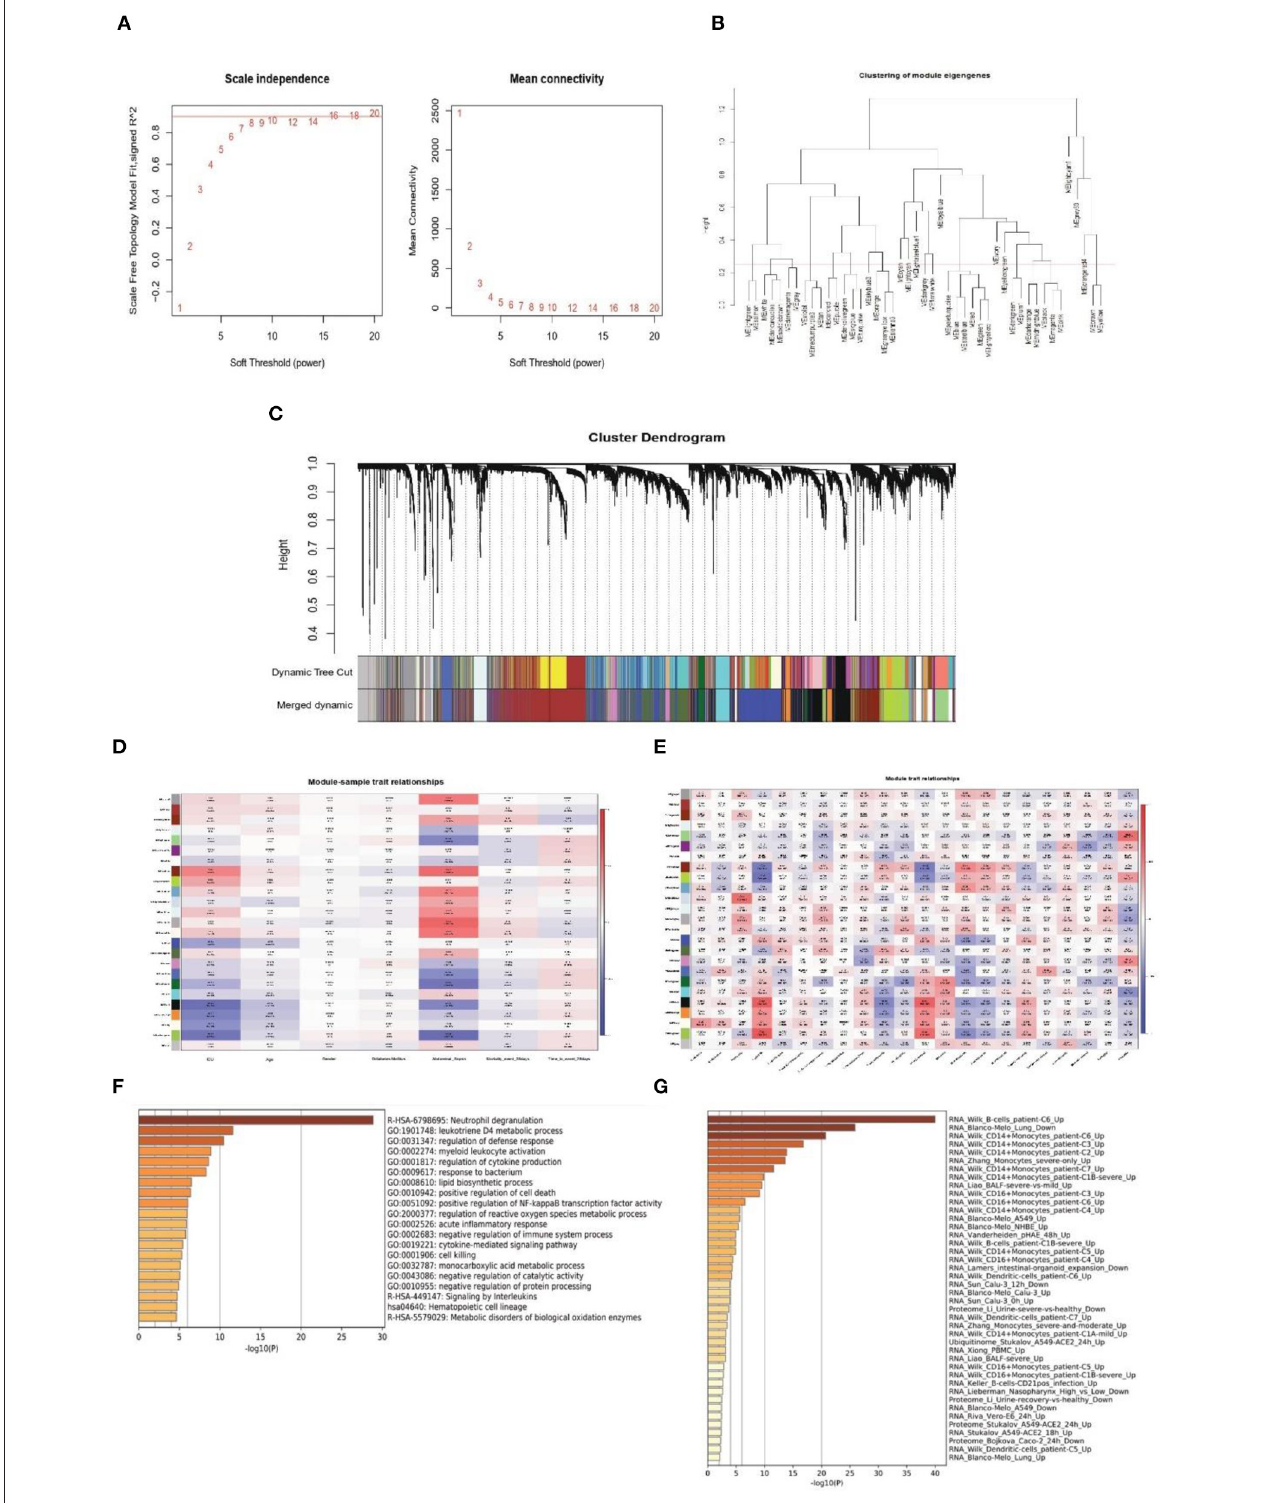
FIGURE 3 | Weighted co-expression network construction and identification of key modules. (A) Correlation between the modules in the network topology analysis for various soft-thresholding powers. (B) Cut height for merging modules. (C) Gene dendrogram and related module colors. (D) Correlation between the 22 modules and sample traits. (E) Correlation between the 22 modules and immune cell scores. (F,G) Functional enrichment analysis of the Darked module genes.